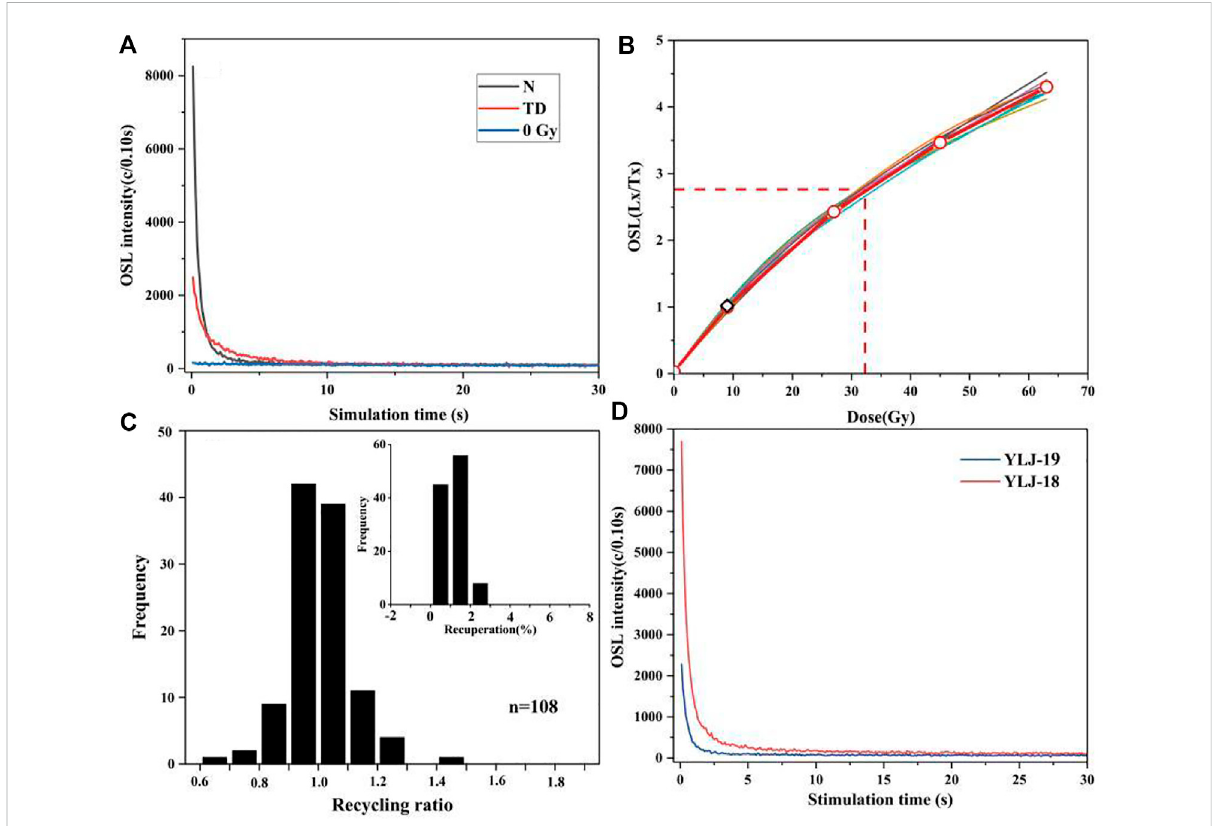
FIGURE 7 Luminescence characteristics of sample aliquots. (A) Decay curves of the OSL signals for sample YLJ-17; (B) growth curves of the OSL signals obtained usingtheSARprotocolfor sampleYLJ-17.The datawere fi ttedusinganexponentialpluslinear function. Thethickredcurves representthe fi tted standard growth curve; diamonds and circles represent regeneration OSL signals, where circles represent R1~R5 and diamonds represent R1 ′ . The square and dotted red lines indicate the sensitivity-corrected natural signal; (C) recycling ratios and recuperation values of all quartz aliquots; (D) decay curves of OSL signals for samples YLJ-18 and